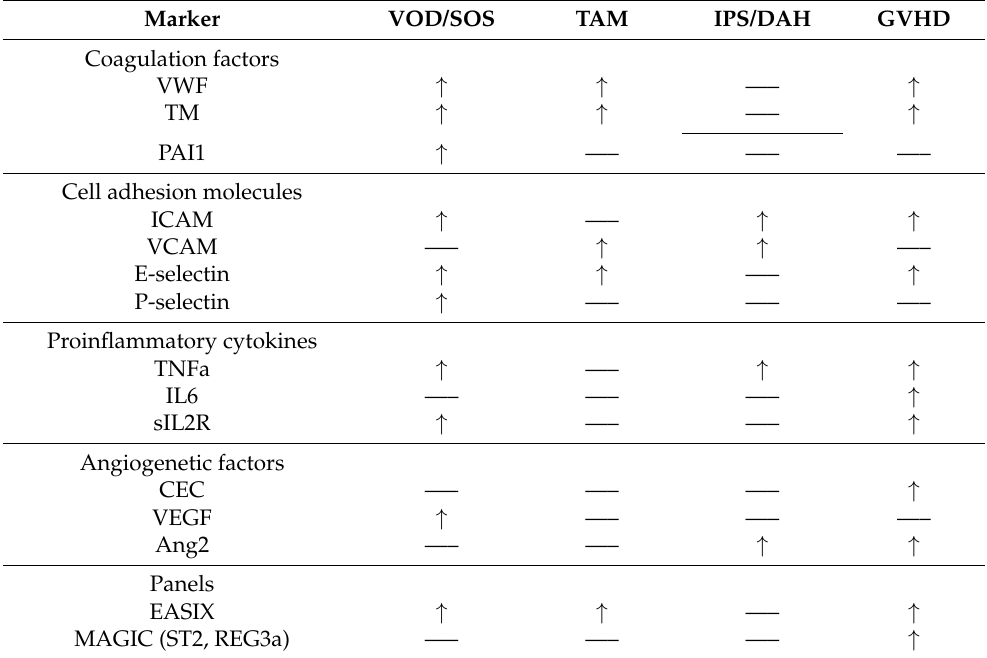
Table 3. Biomarkers associated with endothelial dysfunction related post-transplant syndromes.